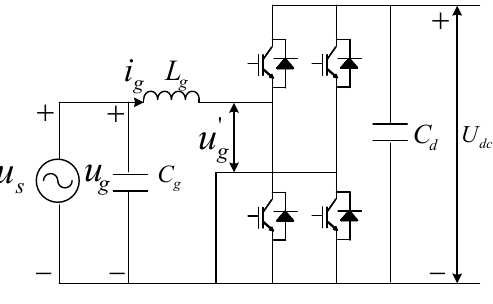
Figure 7. The circuit topology of